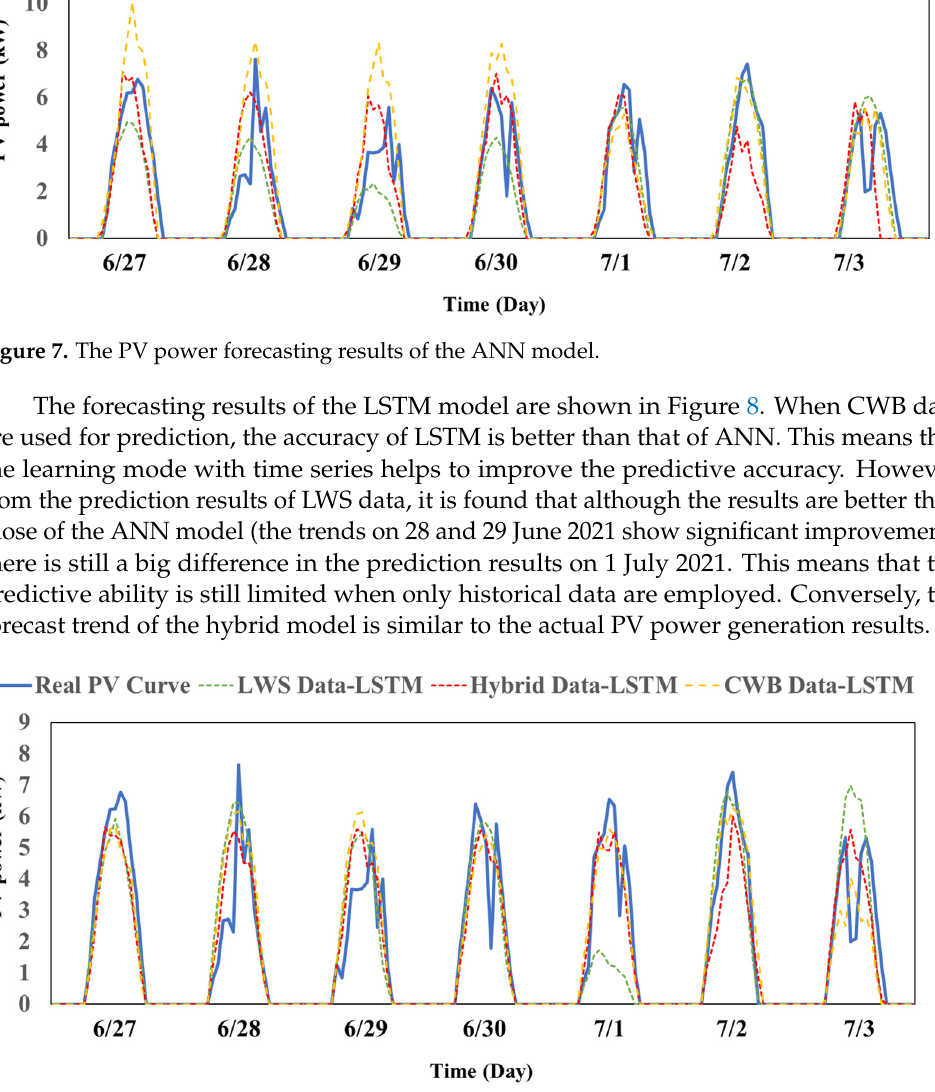
Figure 8. The PV power forecasting results of the LSTM model.